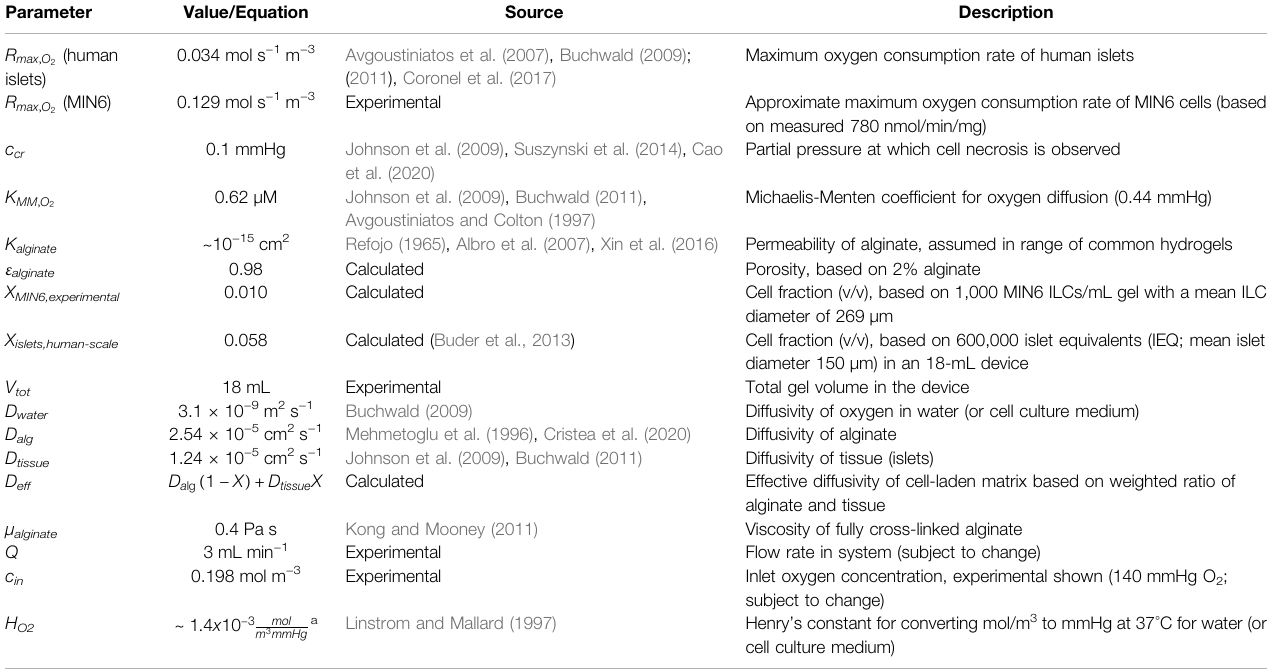
TABLE 1 | Computational model parameters for a perfused macroencapsulation device.